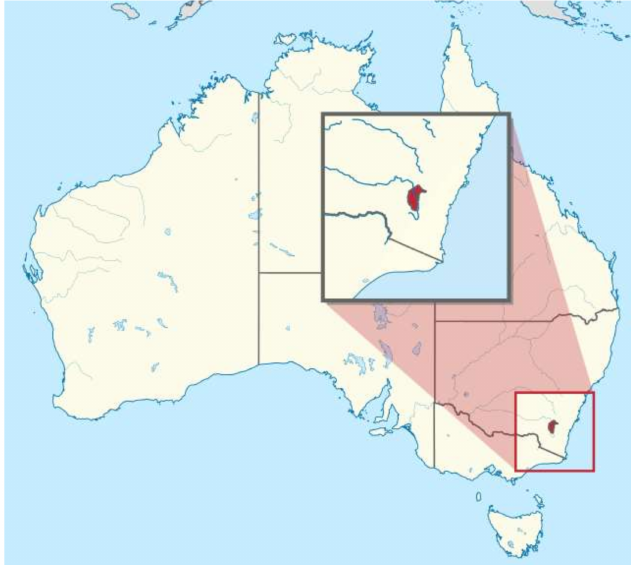
Figure 1. Map of Australia identifying the Australian Capital Territory (ACT). Note: Image used with permission under the Creative Commons Attribution-Share Alike 3.0 Unported